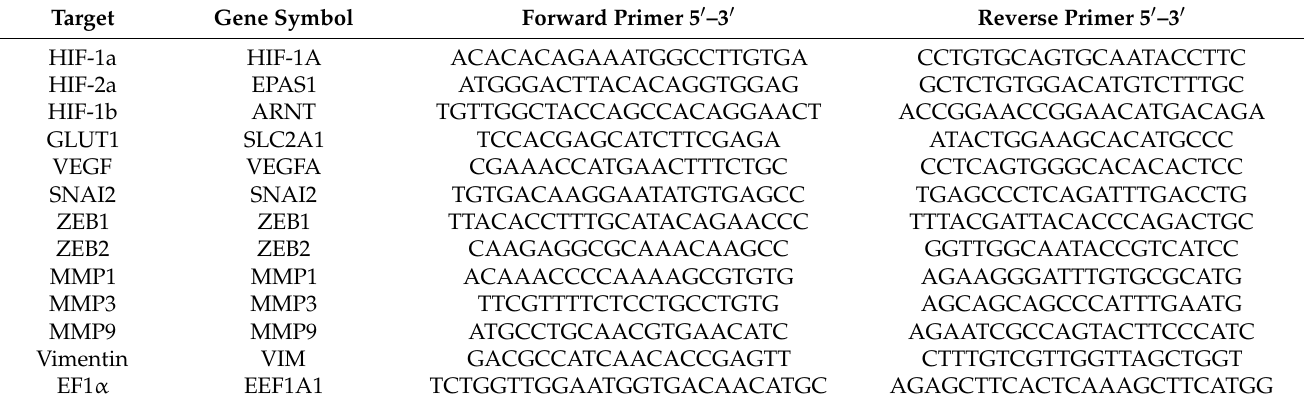
Table 1. Primers used for the real-time polymerase chain reaction